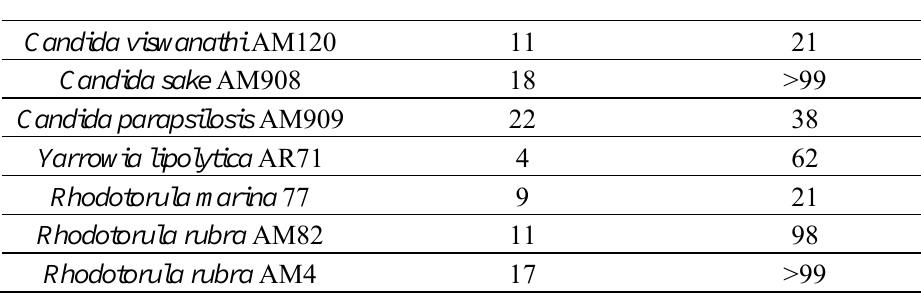
Table 5. The conversion (according to chiral gas chromatography, CGC) after 21 days of diol 3f in the course of screening-scale oxidation conducted in